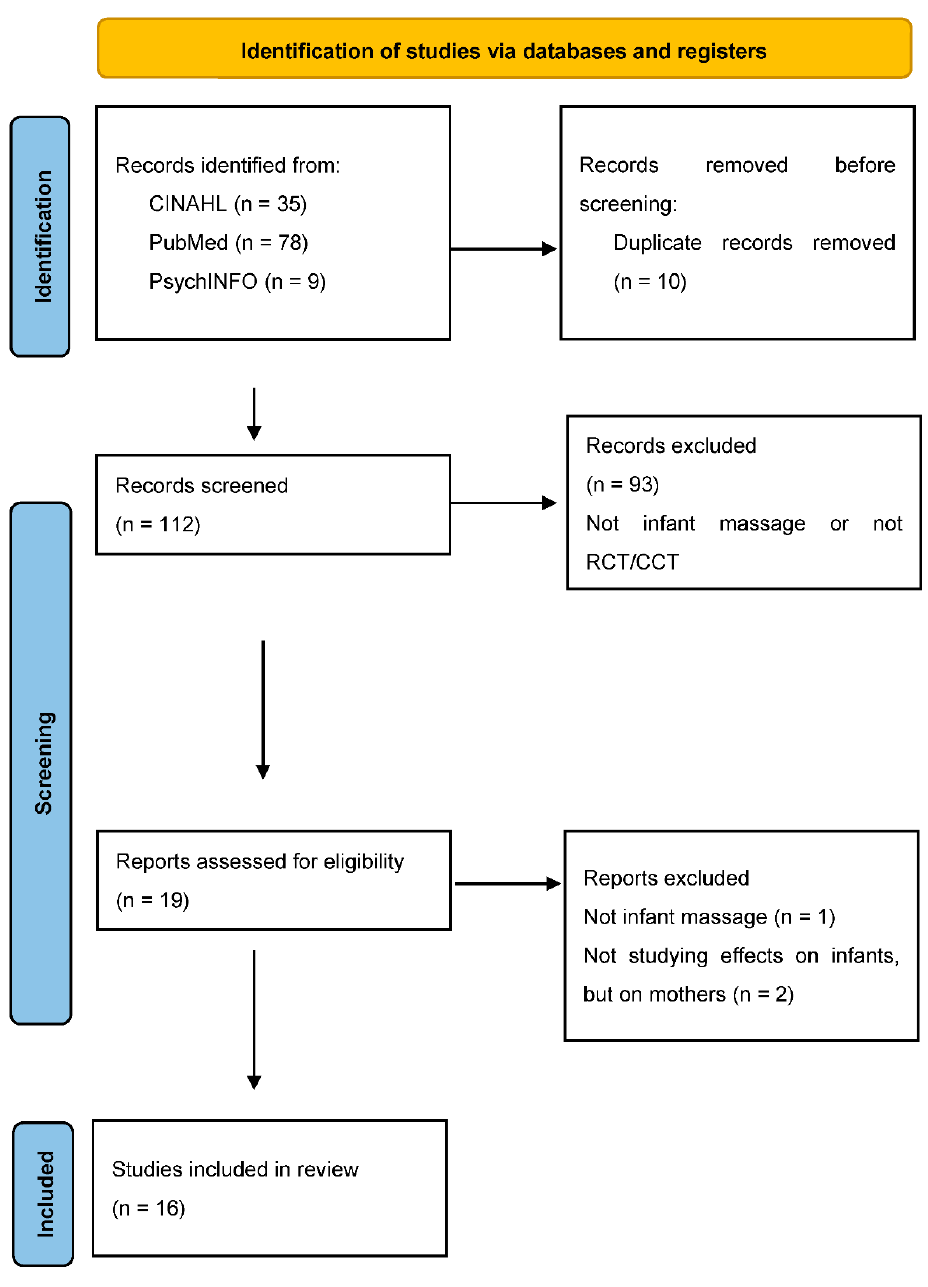
Figure 1. PRISMA flow diagram of the study selection process. From: Page, M.J.; McKenzie, J.E.;